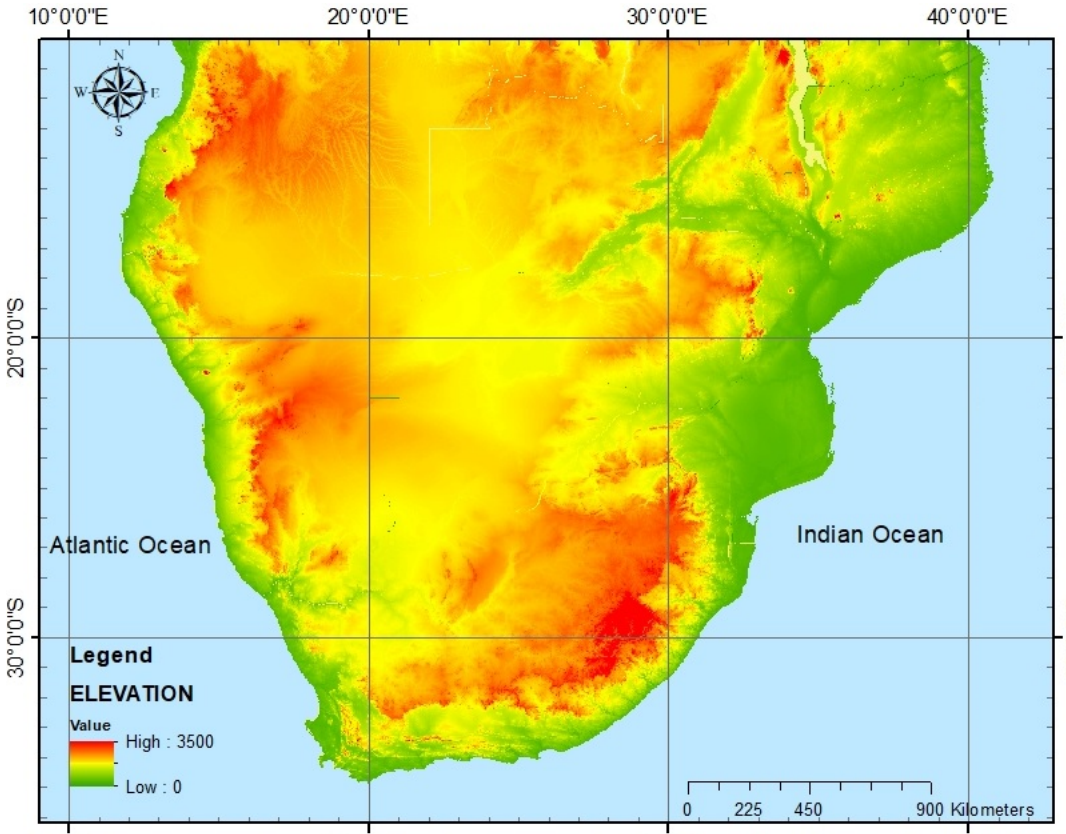
Figure 2. Southern Africa elevation map.